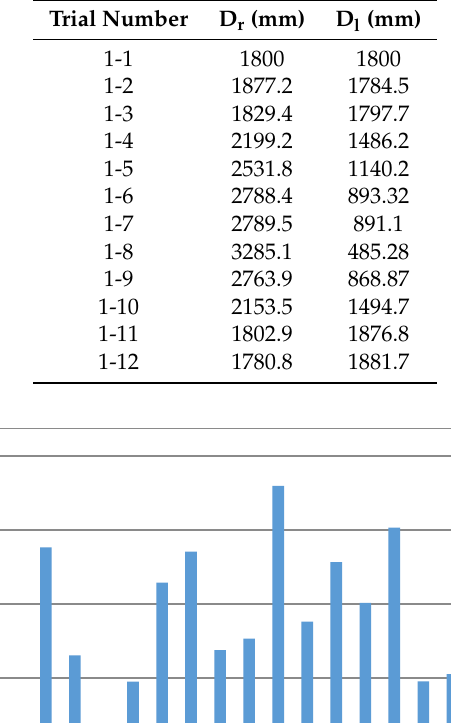
Table 2. Result of self-localization.